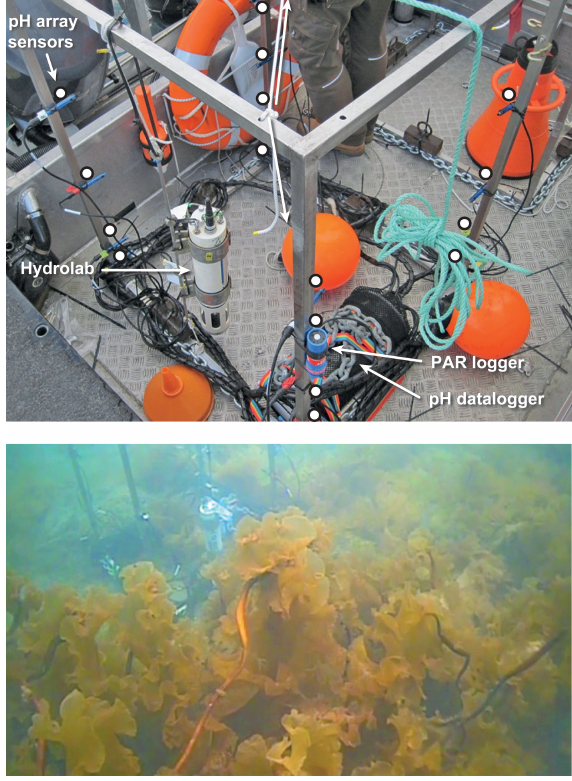
Figure A1. Photo of deployment frame with loggers shown on the deck of the boat (upper panel) and in situ in the Saccharina longicruris - dominated kelp forest (site #1, central panel). Markings in upper panel show the array of 16 pH sensors connected to a common pH logger; the Hydrolab instrument measuring salinity, temperature and oxygen; and a PAR logger